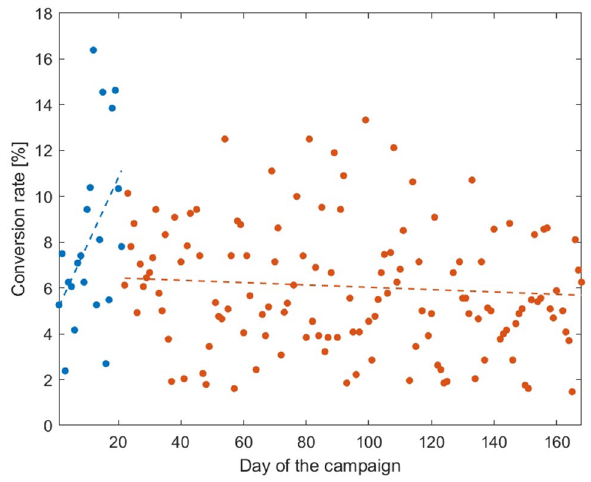
Figure 1. Conversion rate per day over the duration of the advertising campaign. The first 21 days of the campaign are colored in blue and the rest in brown. Conversion rate rose during the first 21 days of the campaign (as indicated by the blue regression line) and then plateaued (as shown by the brown regression